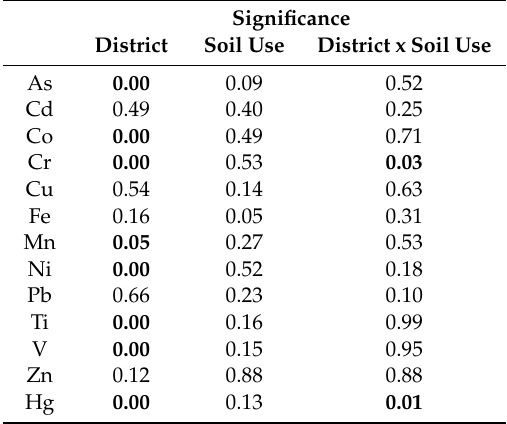
Table 2. Main e ff ects of district, soil use, and interaction district x soil use on pseudo-total PTE concentrations (significance level).